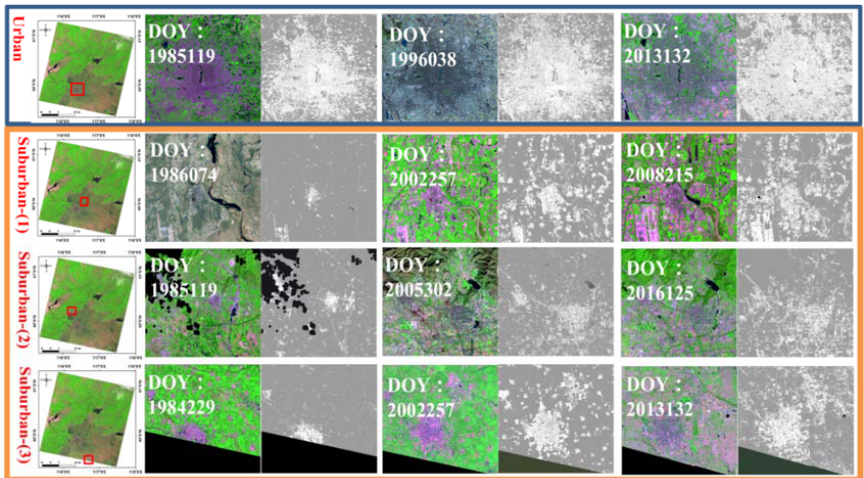
Figure 4. Original classification maps for an urban region (Beijing city center) and several regions (Shunyi: suburban-1, Changping: suburban-2, and Langfang: suburban-3) on different dates. Note that the selected dates differ by region. In each panel, the color map shows the original Landsat data with RGB-5, 4, 3, and the binary map shows the extracted urban areas (white). In the latter set of maps, gray indicates non-urban areas and black indicates that data are unavailable due to cloud contamination or other reasons.